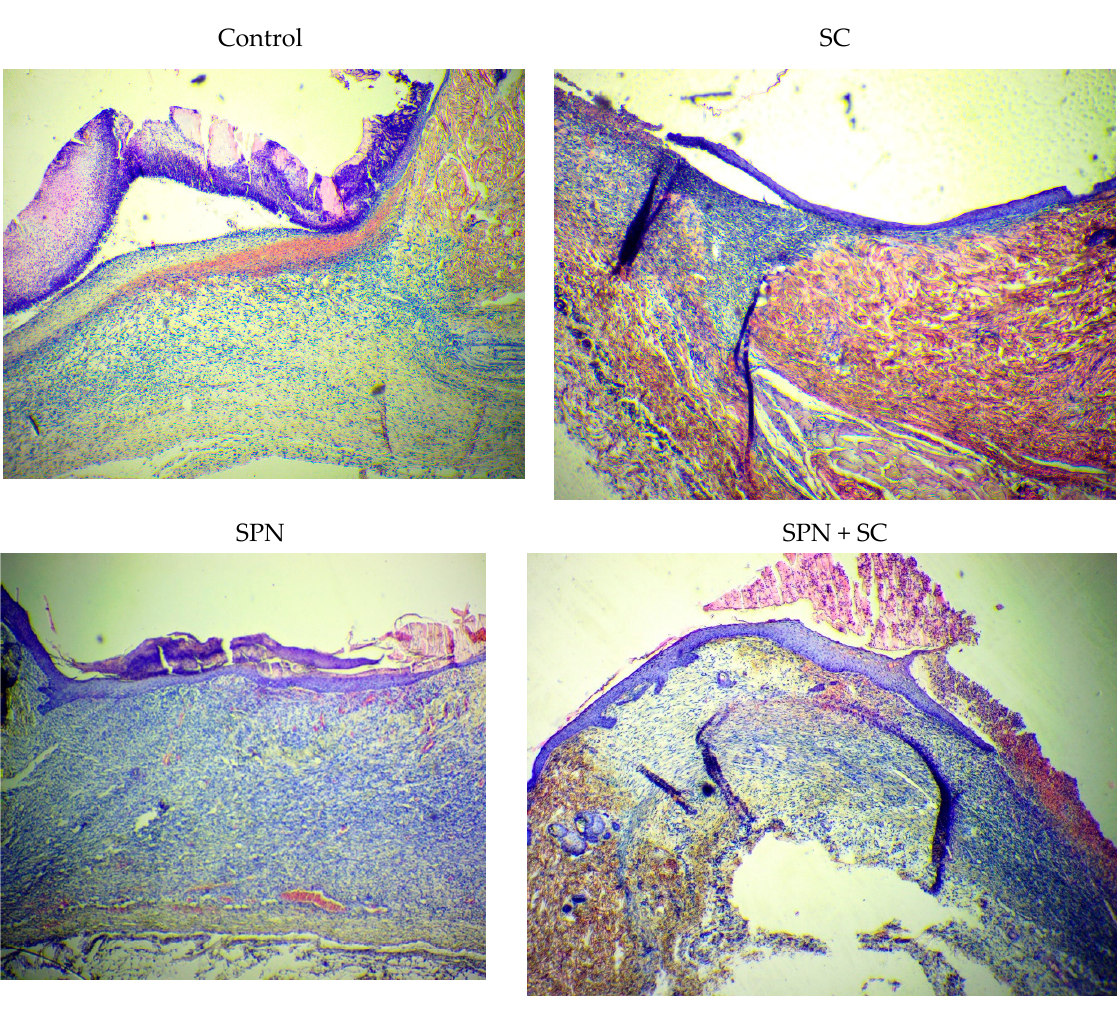
Figure 11. Edge of wounds in different groups on day 7 (Hematoxylin–Eosin, magnification ×40). On the 14th day of the study, regional differences in the content of both resident and non-resident cells were not recorded in all groups. In the center and on both edges of the wounds, the cell concentration was comparable. This may be due to the restoration of the depth of damage by increasing the epithelialization of most wounds. The predominance of fibroblasts over leukocytes during this period demonstrates the continuing phase of proliferation during this period (Table 3). Table 3. The content of resident and non-resident cells in the center and edges of wounds of different groups on day 14 (%). Groups